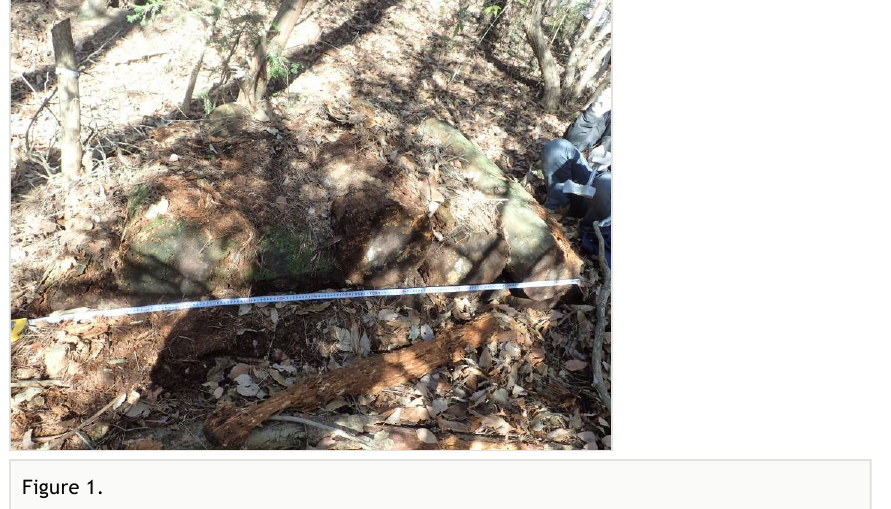
The nest of Polyrhachis lamellidens in which microdontine larvae and puparia were